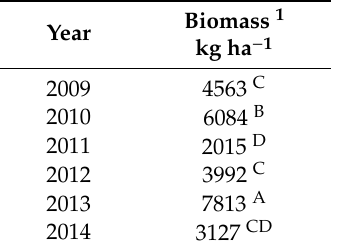
Table 3. Avearge annual forage biomass production by year, pooled across treatments.